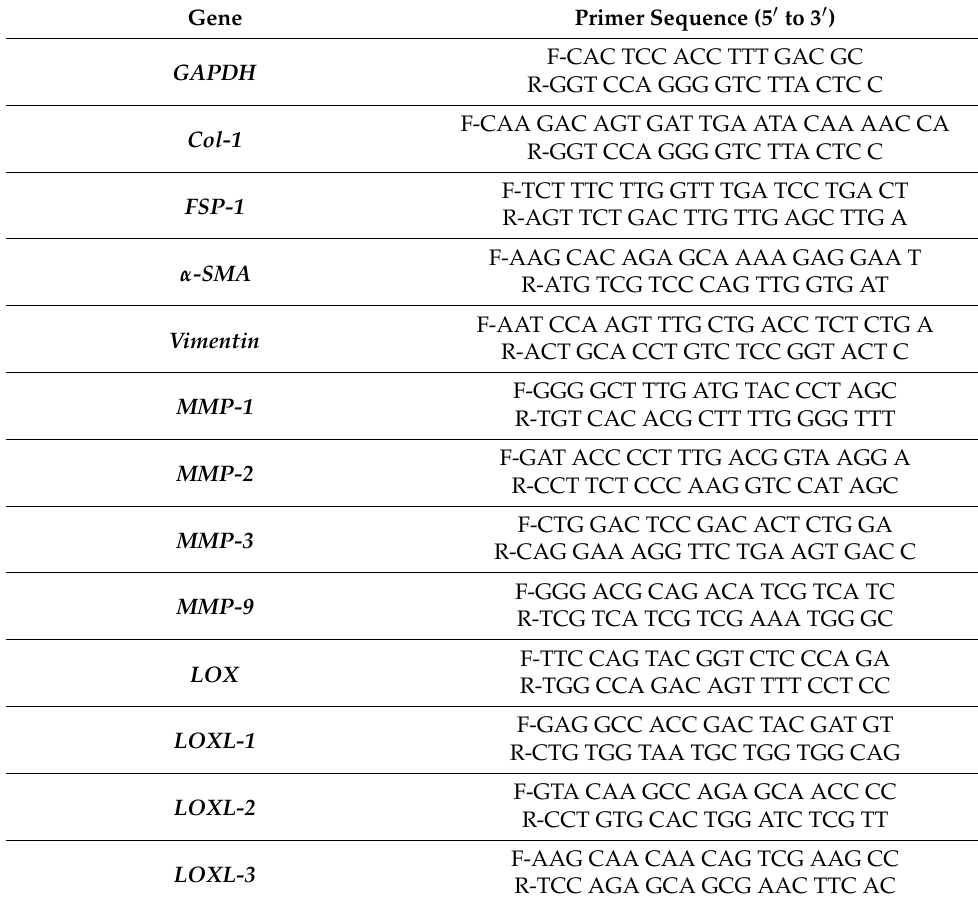
Table 2. List of primers used for